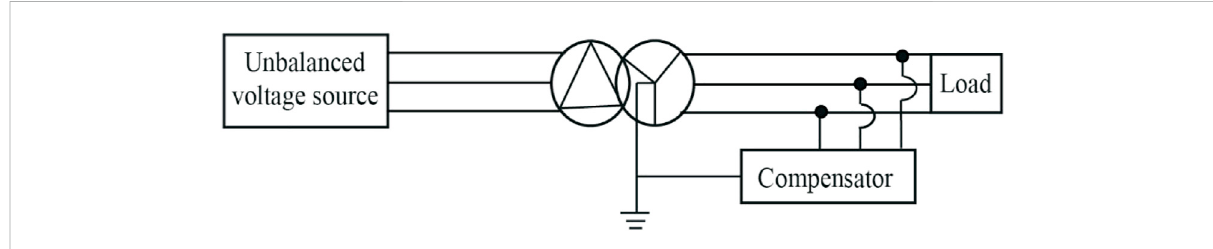
FIGURE 1 Power network with unbalanced voltage source.